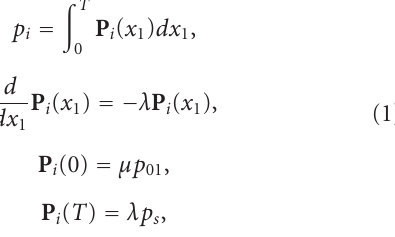
Figure 3: Birth-death process of CPU